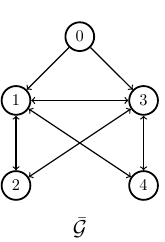
Figure 8. The reliable and connected communication network ¯